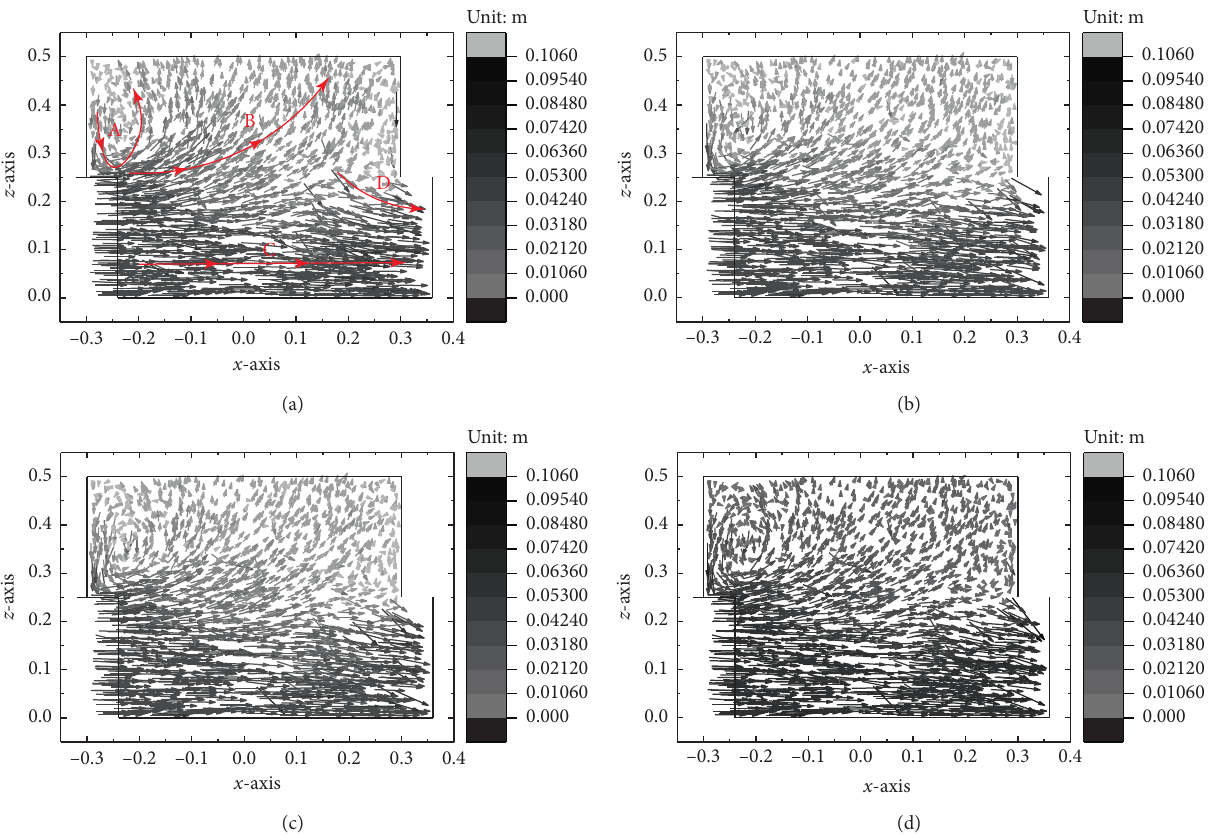
Figure 14: The displacement of particles: (a) σ